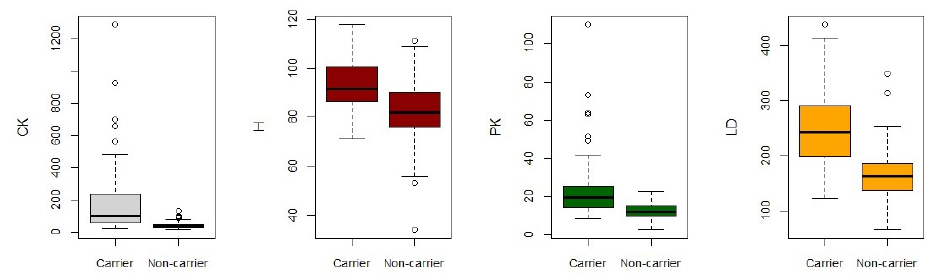
Figure 1. Information from DMD dataset.